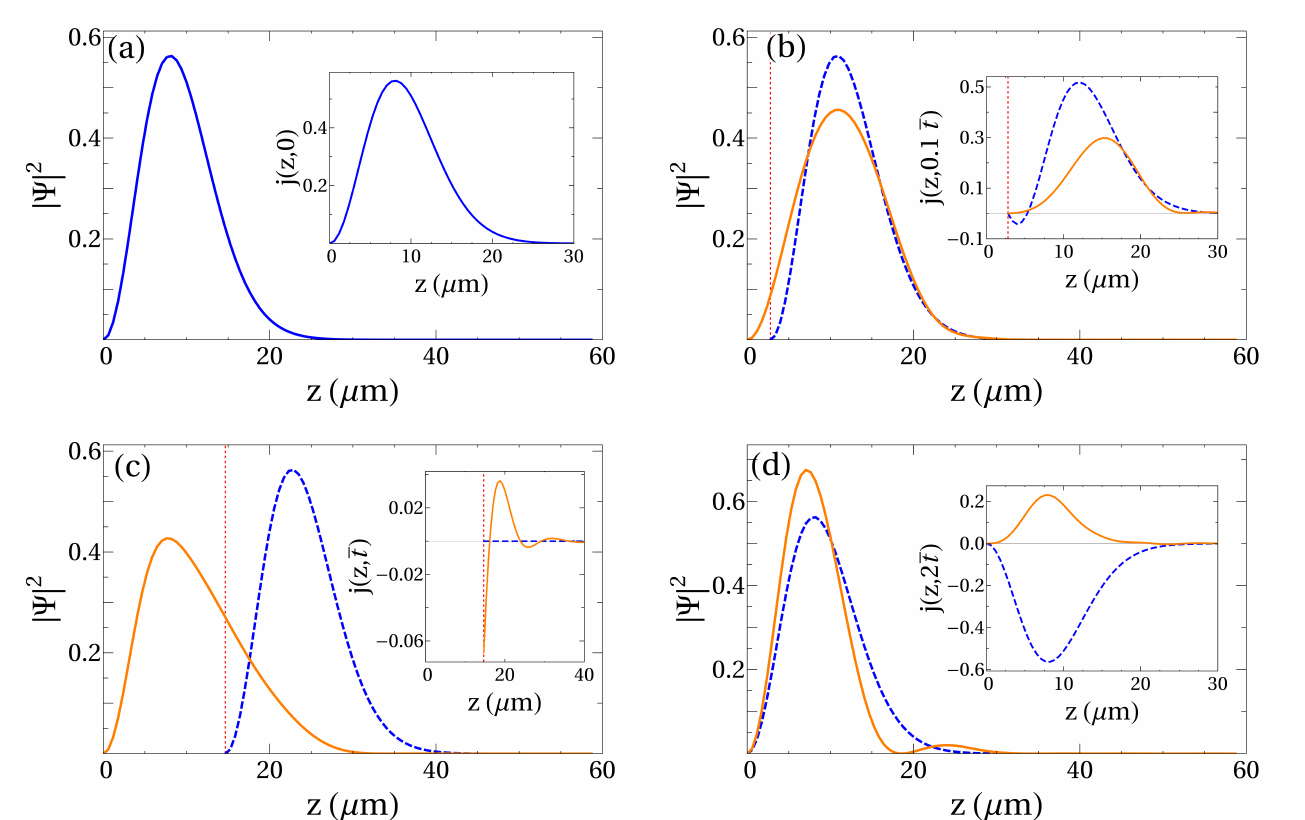
Figure 1. Snapshots of the time evolution of the probability density and the current density (shown in the insets) for a neutron prepared in the ground basis state of the moving mirror Ψ ( z ,0 ) = ψ 1 ( z ,0 ) . ( a ) shows the initial state ( t = 0); ( b – d ): The probability density | Ψ F | 2 and corresponding current when the mirror is fixed are shown in orange; the blue dotted lines represent | Ψ M | 2 and j M when the mirror is moving. The position of the mirror is indicated by a vertical red line. These snapshots are taken ( b ) at t = ¯ t /10; ( c ) at t = ¯ t (when the mirror reaches its maximum position); ( d ) at t = 2¯ t (the mirror returns to its initial position). The parameters of the mirror in gravitational units are a = − 0.1, b = 1 and c = 0, which sets ¯ t = 5 t g . The values shown in the plots have been rescaled from the gravitational unit values by using the neutron mass and the Earth’s surface gravitational acceleration g , giving L ( ¯ t ) = 14.67 µ m at ¯ t = 5.47